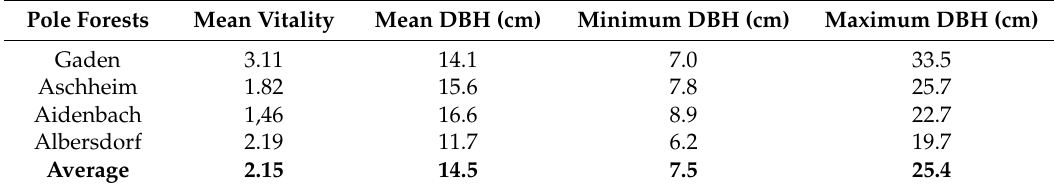
Table 2. Mean vitality and diameter of trees at breast height in the additional study sites.